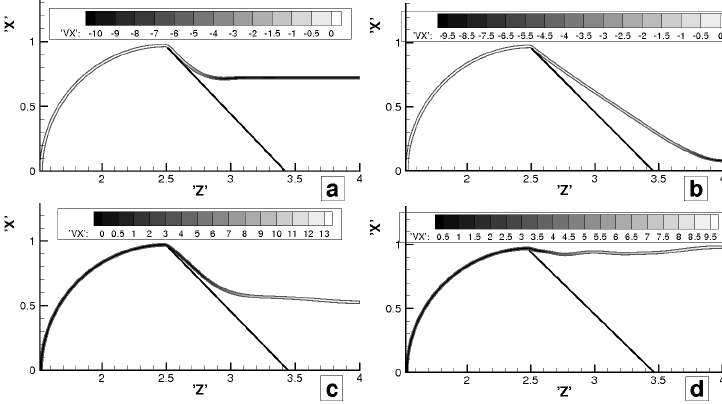
Figure 6. The thermoelastic liner positions for different times ( t = 0 . 061; 0.117; 0.172; 0.215